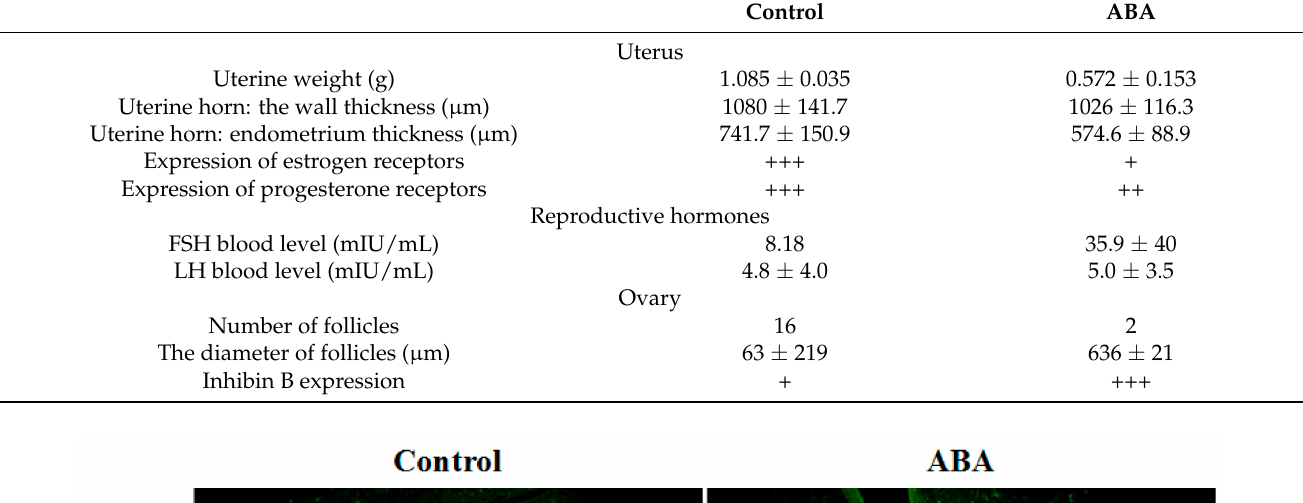
Table 3. Reproductive parameters and hormonal profiles in the control group and in animal model of anorexia nervosa. + = low expression, ++ = moderate expression, +++ = high expression.